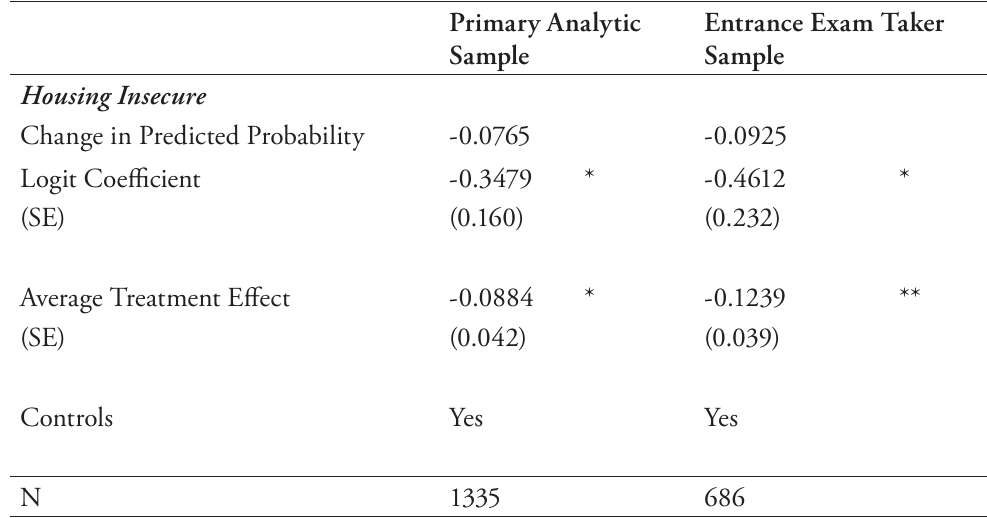
Table 2: Relationship between housing insecurity and later educational